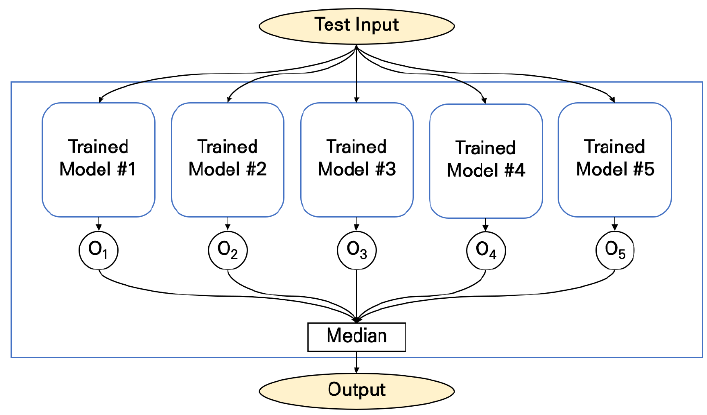
Figure 10. Ensemble method.